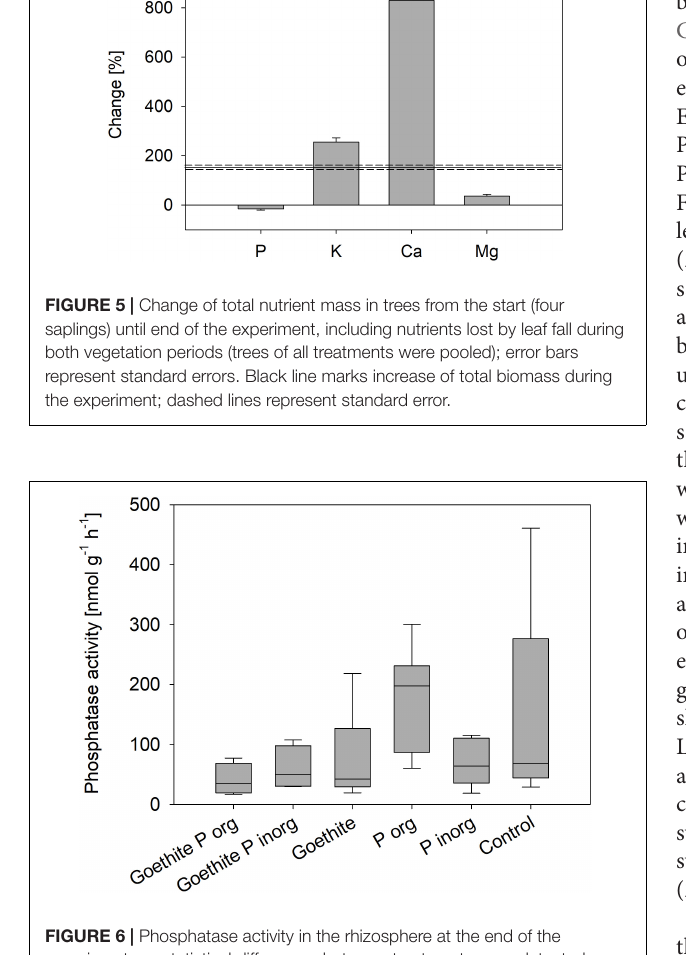
FIGURE 6 | Phosphatase activity in the rhizosphere at the end of the experiment; no statistical differences between treatments were